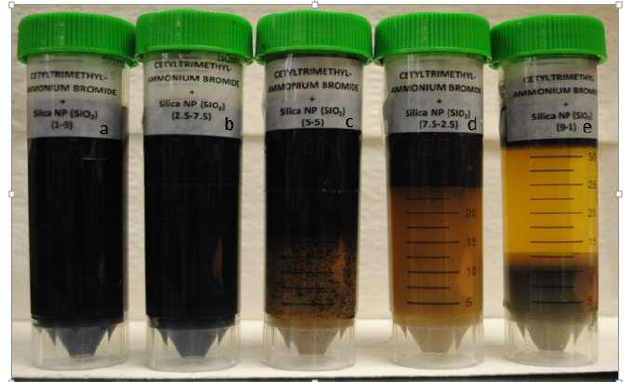
Figure 9—CTAB with SiO